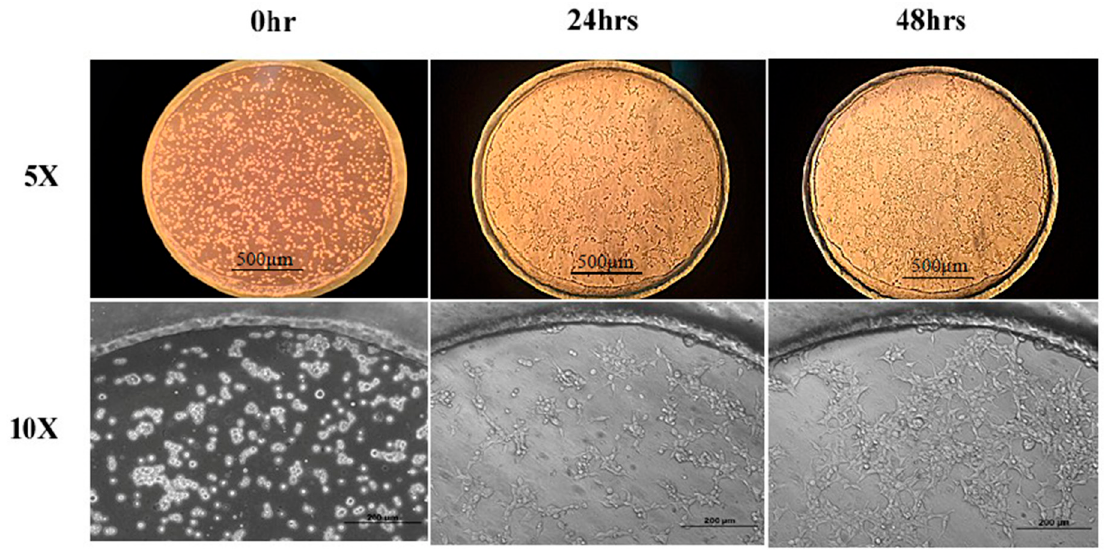
Figure 4. HEK293-GPR120 cells cultured in a well array for 48 h. Scale bars: 500 µm for 5 × pictures, 200 µm for 10 × pictures.